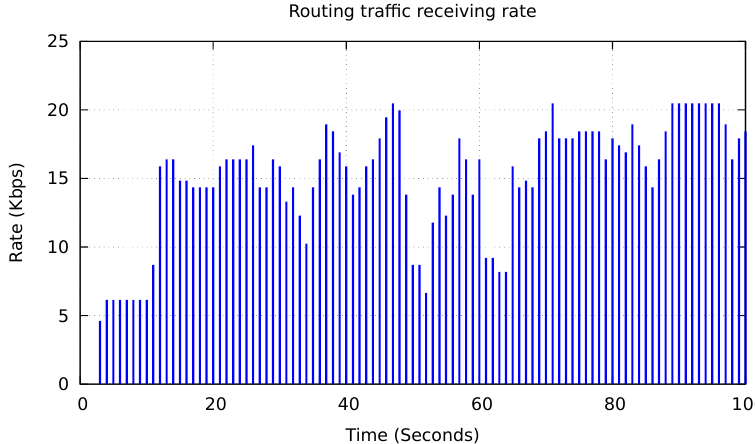
Figure 6. Routing traffic receiving rate.